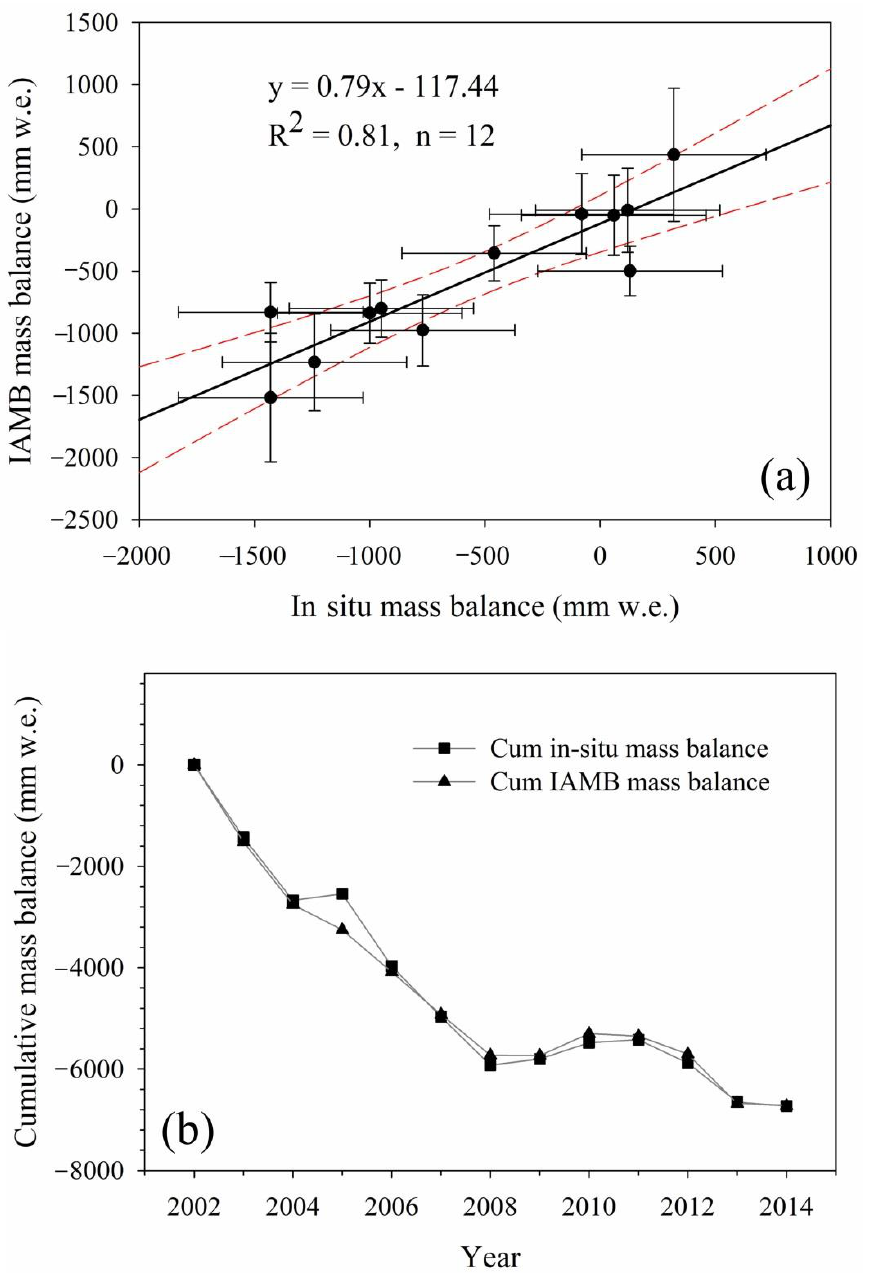
Figure 7. ( a ) Relationship between in situ mass balance and mass balance reconstructed using the IAMB method. The red dashed lines show the 95% confidence intervals. ( b ) Cumulative in situ and reconstructed mass balances for the Chhota Shigri glacier for the period 2003 – 2014.